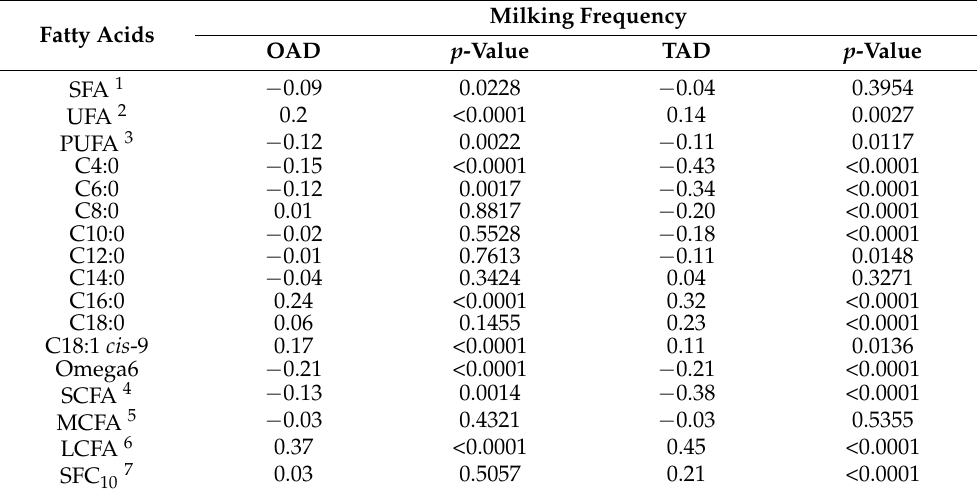
milked OAD except for C4:0 and C6:0. Correlation between fat and C16:0, and fat and C18:1 cis -9 were week and positive in both milking frequencies. In cows milked TAD the correlation between fat and solid fat content was signi fi cant and positive. Table 3. Partial correlation coefficients between fat percentage and fatty acid composition of cows milked once a day (OAD) and twice a day (TAD). Fatty